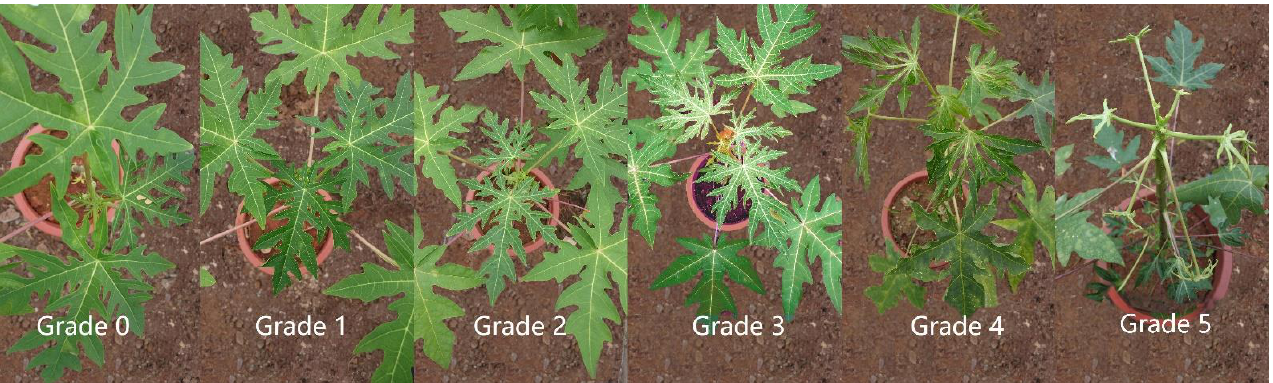
Figure 1. Picture of papaya seedling stage with disease index of grade